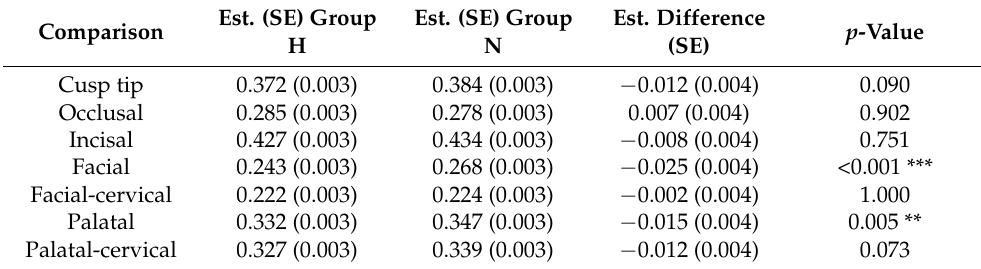
Table 4. Between-group comparison of local thickness values (mm) from group high (H) and narrow (N) aggregated for measurement location. Comparison was achieved using a multiple compari- son post hoc test with Tukey-method for p -value adjustment (family of 14 estimates), respectively. ** p < 0.01, *** p <